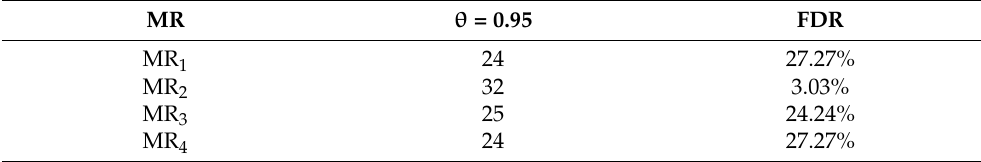
Table 9. Fault detection rate of flair type images.